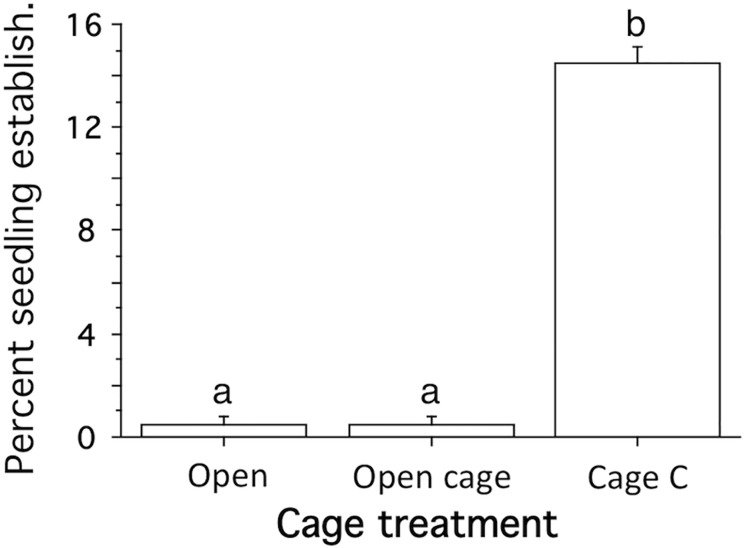
Eight-month cage experiment: Seedling establishment.Seeds with no cage (Open), cage with small holes that let predators in, but prevent seed transport by hydrodynamics (Open Cage) and seeds protected with cages (Cage C). Different letters above bars denote significant different means (SNK-test at P<0.05). 200 seeds planted per plot. Mean+SE.